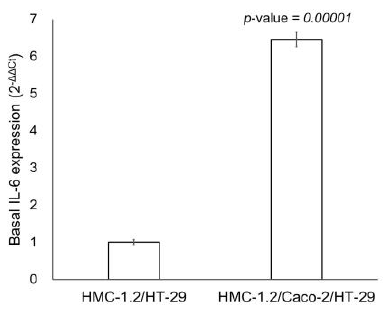
Figure 4. IL-6 gene expression analysed by RT-qPCR in HMC-1.2 interfaced with HT-29 and with the Caco-2/HT-29 co-culture. Results are reported as mean ± SEM of three independent experiments. Statistical analysis: Student’s t test.